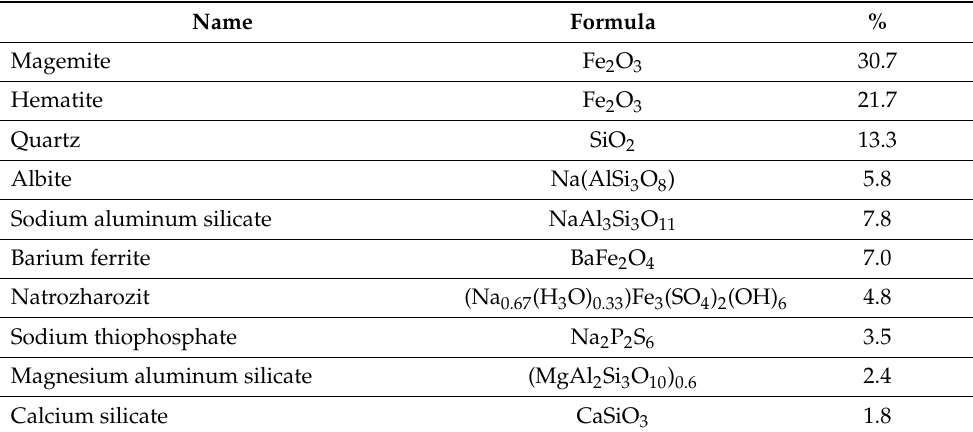
Figure 2. X-ray pattern of pyrite cinders after thermochemical activation. Figure 2. X-ray pa tt ern of pyrite cinders after thermochemical activation. Table 2. Phase composition of pyrite cinders after thermochemical Table 2. Phase composition of pyrite cinders after thermochemical activation.